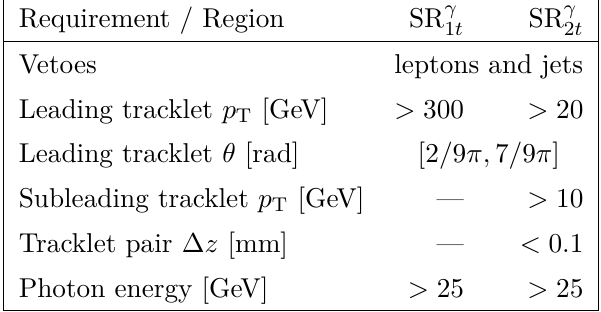
Table 2. Definition of the signal regions used in the analysis.